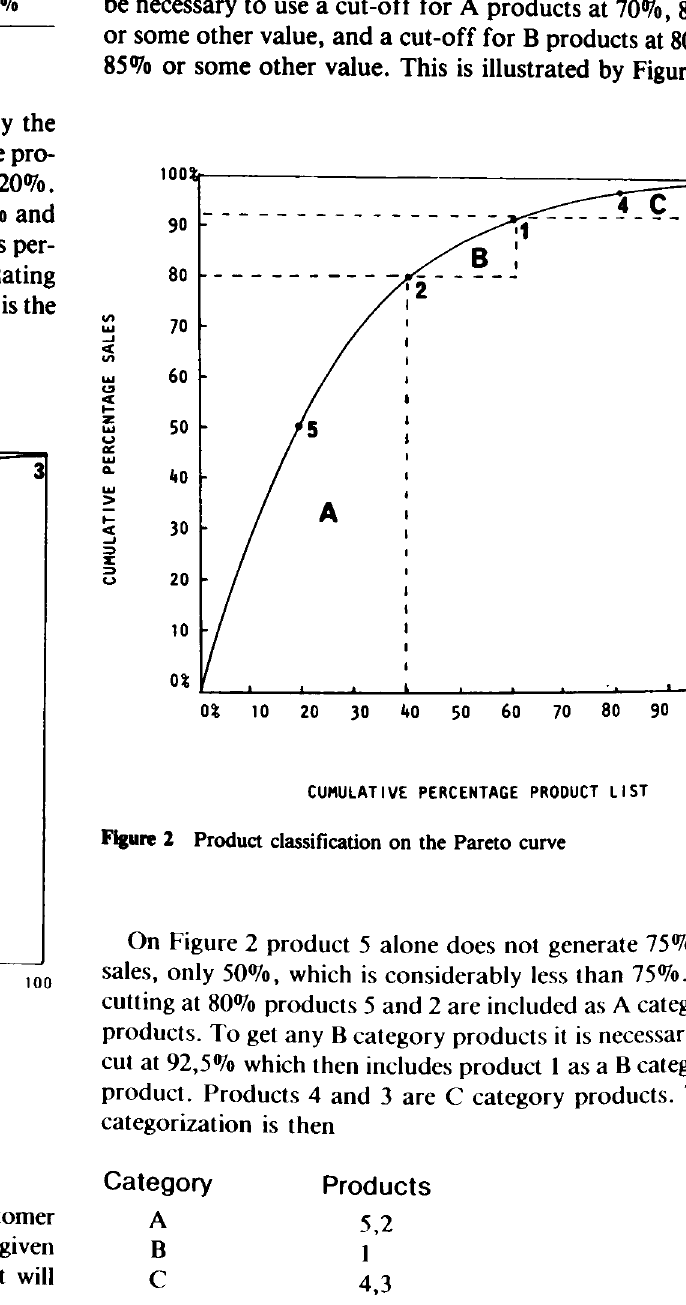
On Figure 2 product 5 alone does not generate 750'/o of sales, only 500'/o, which is considerably less than 750'/o. By 100 cutting at 800'/o products 5 and 2 are included as A category products. To get any B category products it is necessary to cut at 92,50'/o which then includes product I as a B category product. Products 4 and 3 are C category products.